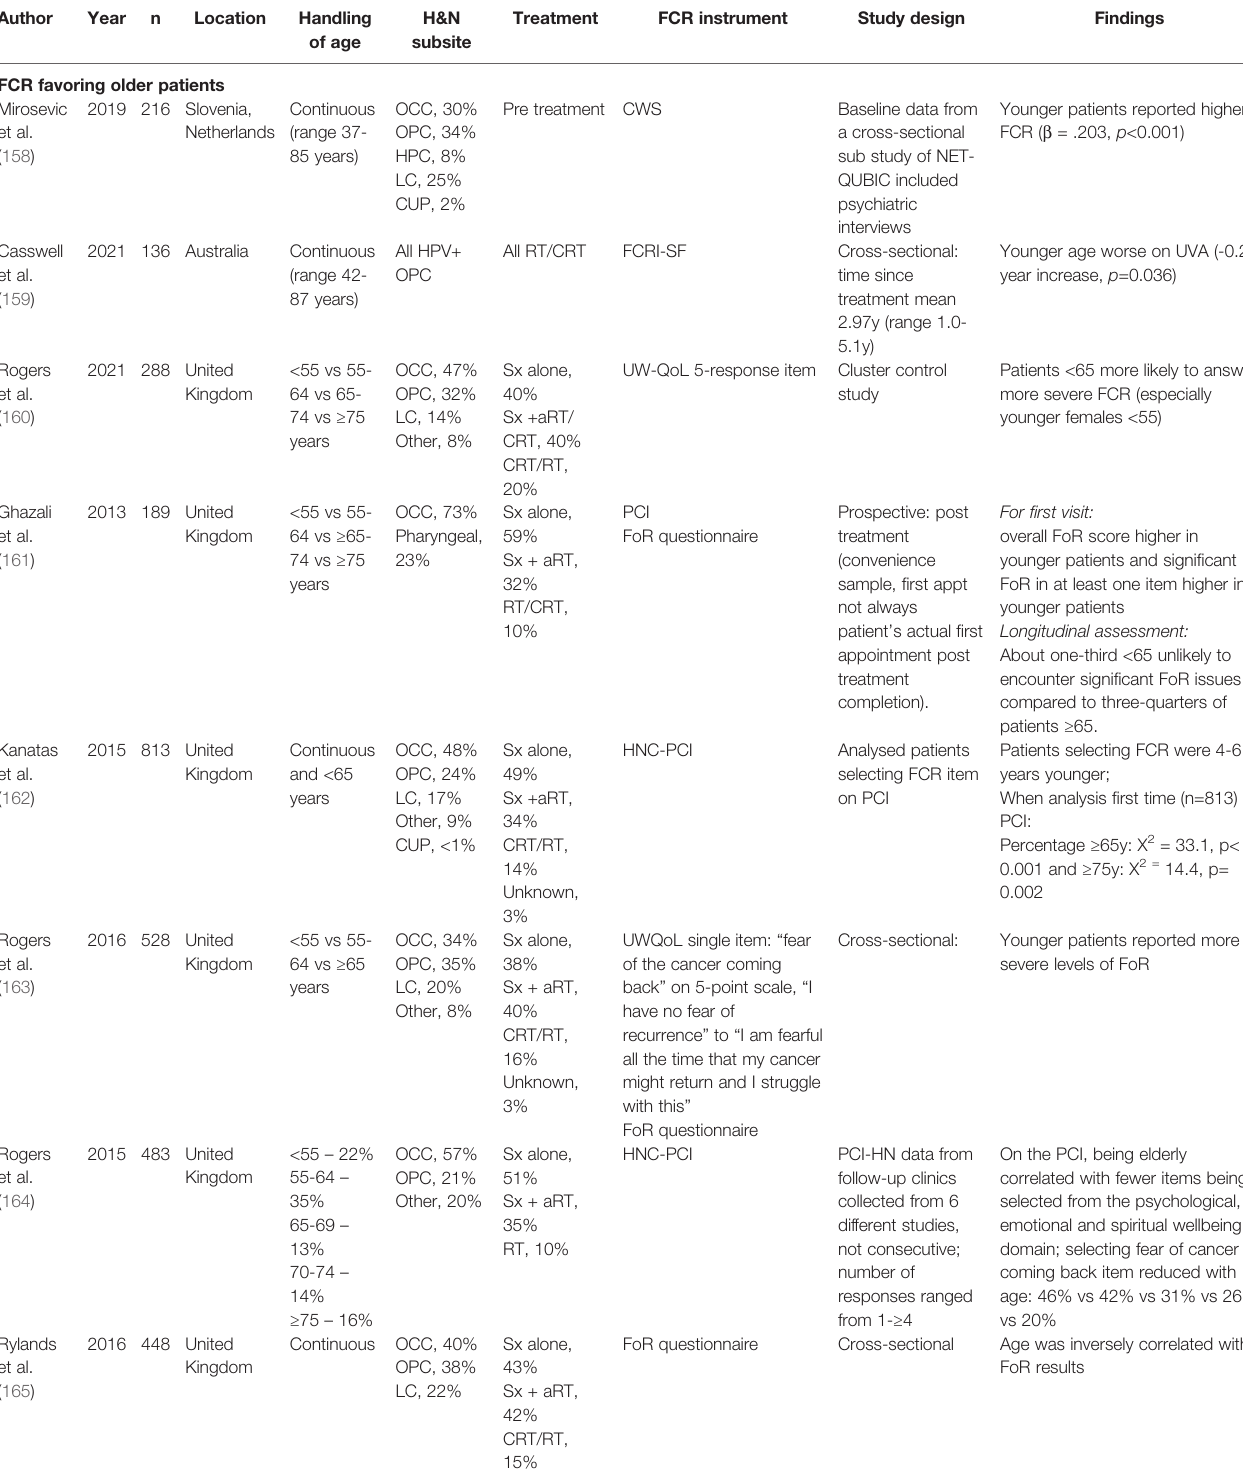
TABLE 9 | Head and neck cancer studies reporting variations in fear of cancer recurrence measures by